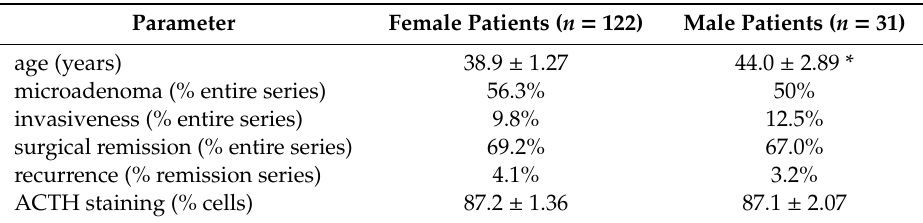
Table 5. Features of female and male patients with Cushing’s